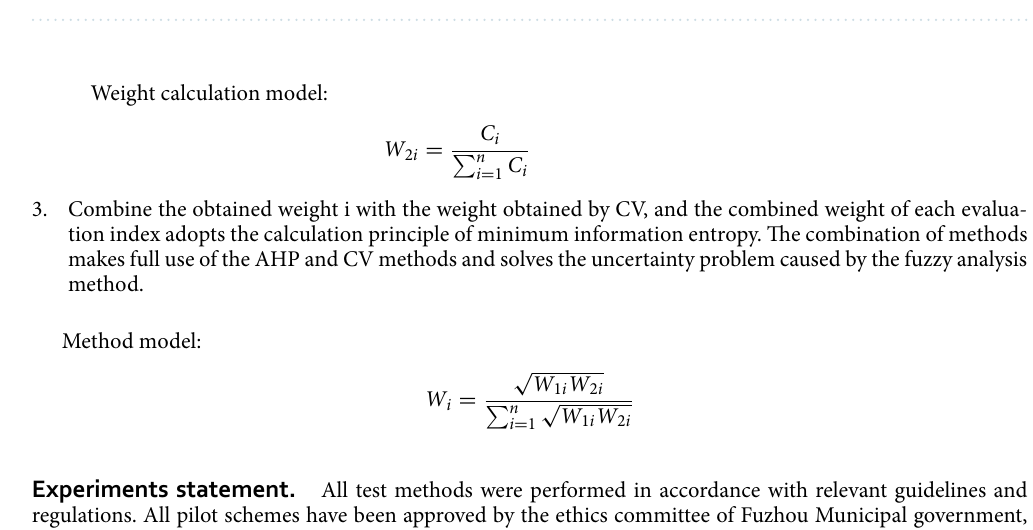
Table 2. Characteristics of